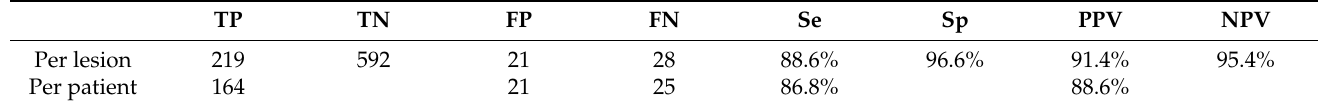
Figure 3. Example of false negative right retro-thyroid gland with insufficient 18 F-choline fixation. 18 F-choline positron emission tomography/contrast-enhanced computed tomography shows no nodular hypermetabolism. Pathology showed hyperplasic parathyroid weighing 80 mg. Table 2. Per-lesion and per-patient contingency tables of the 18 F-choline positron emission tomography/contrast-enhanced computed tomography